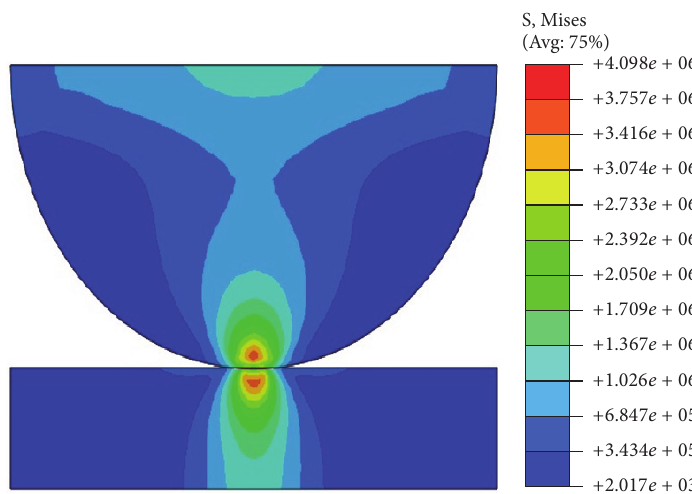
Figure 2: Von Mises stress [Pa]: commercial software, classical theory of